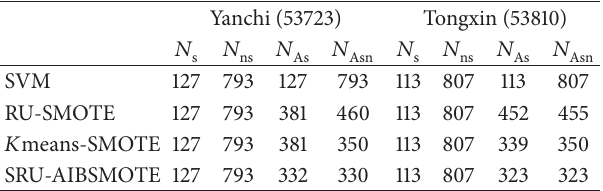
Table 4: Number of the samples with different